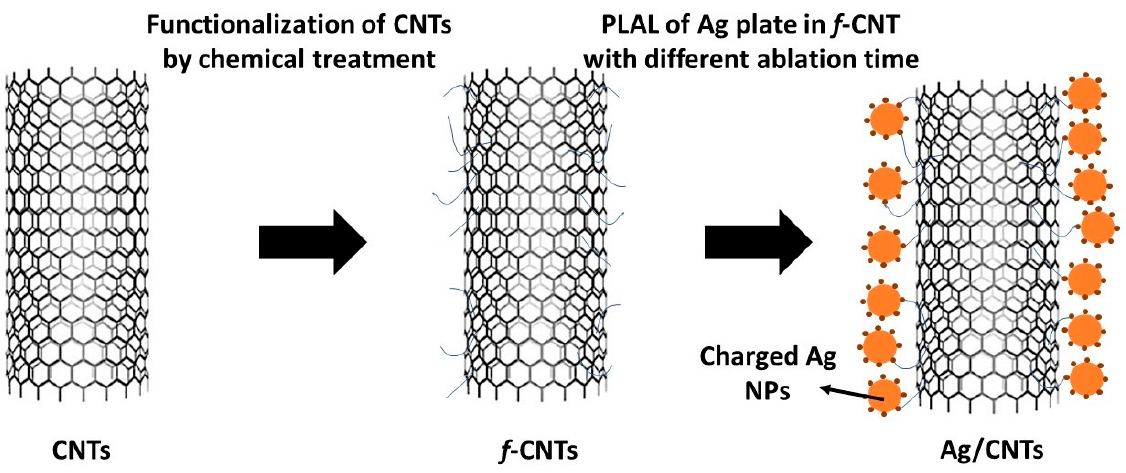
Figure 1. Schematic diagram of the used CNTs and their decoration by Ag NPs with different concentrations based on tuning laser ablation time.